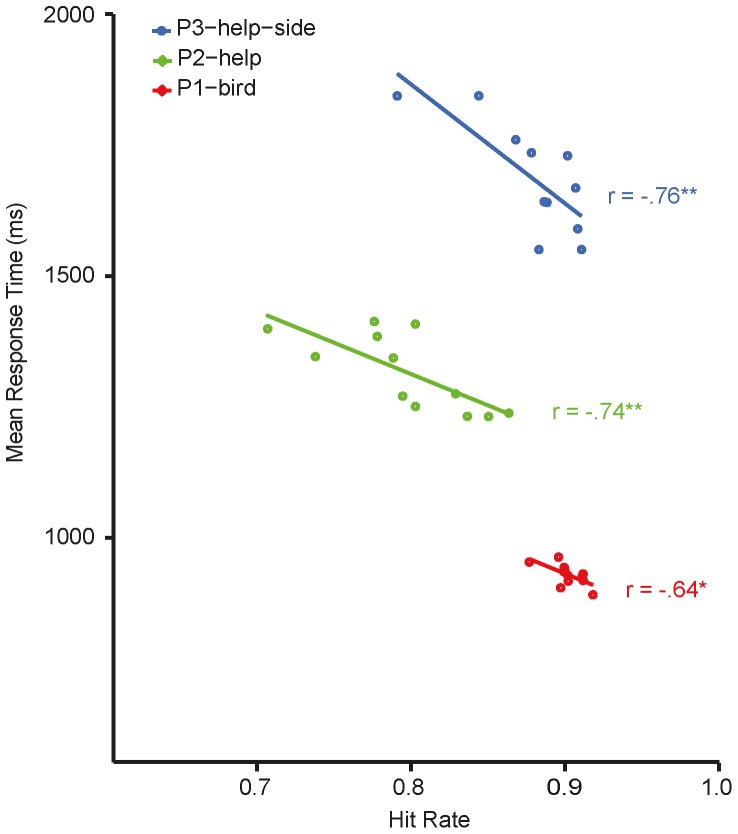
Relationship between hit rates and mean RTs.Each data point shows the mean RT for one situation as a function of its hit rate. Means and correlations were calculated separately for P3-help-side (blue), P2-help (green) and P1-bird (red). Asterisks mark significances according to Pearson's correlation tests: **p<.01, * p<.05. Regression lines were calculated by fitting linear models.